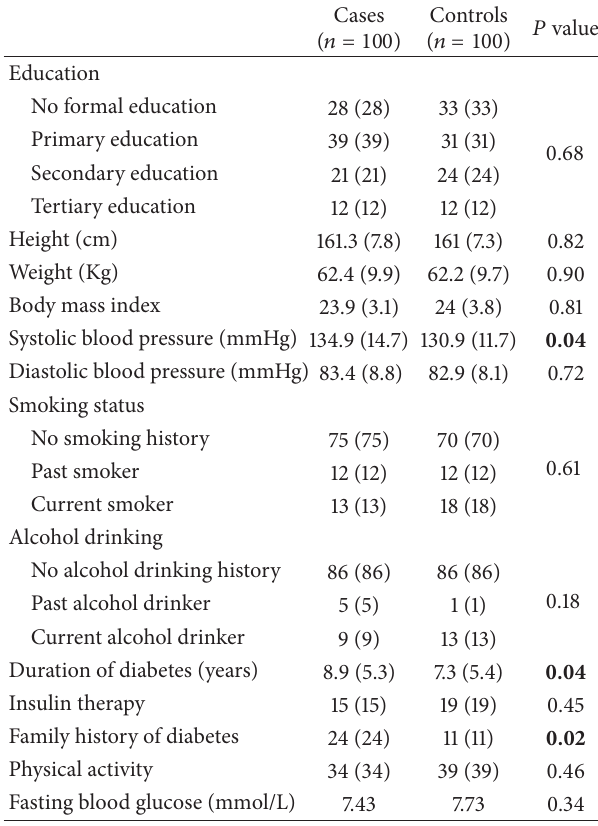
Table 2: Characteristics of study